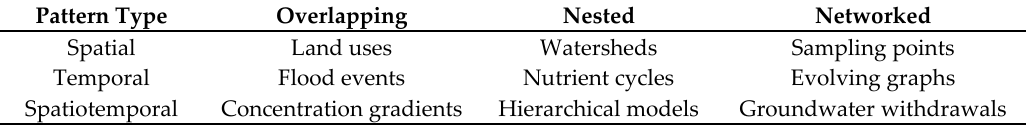
Table 1. Examples of various pattern relationships as related to type (spatial and/or